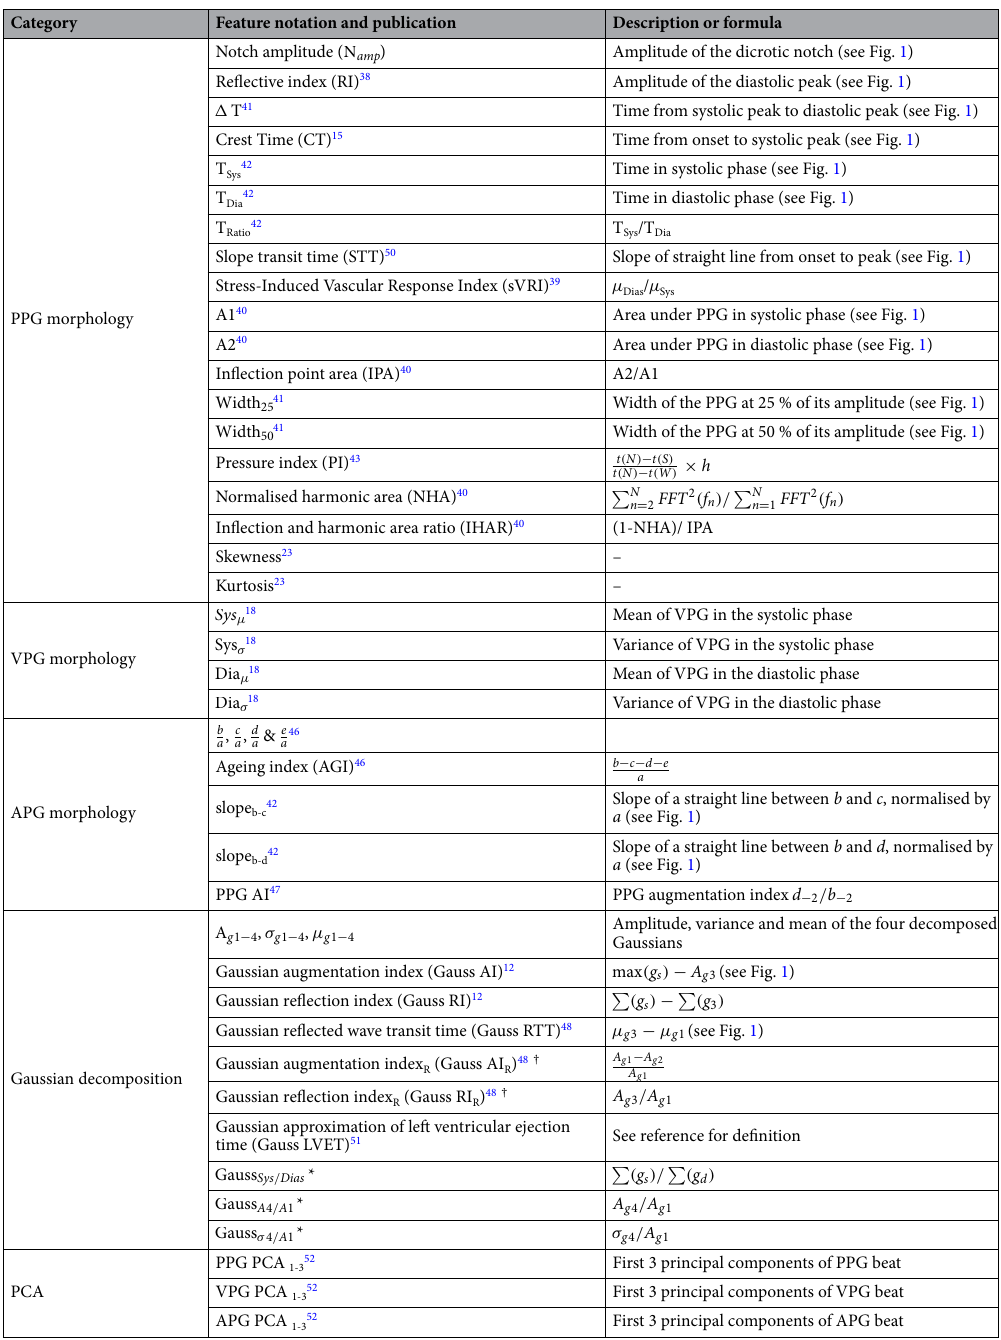
Table 2. Summary of features extracted from the PPG. *Indicates features that, to the authors’ knowledge, have not been previously implemented for BP estimation. † Note that there are two Gaussian indices referenced reflection index and augmentation index. We refer to the second set using the subscript R to reflect the authors: Rubins et al. µ Sys and µ Dias represents the mean of the PPG during systole and diastole respectively. h is the height of the participant. t is the normalised time since the pulse onset. FFT is the fast Fourier transform. g i refers to the i th Gaussian; g s = g 1 + g 2 representing the systolic wave; g d = g 3 + g 4 representing the diastolic wave. (cid:31) ( g i ) is the area under the i th